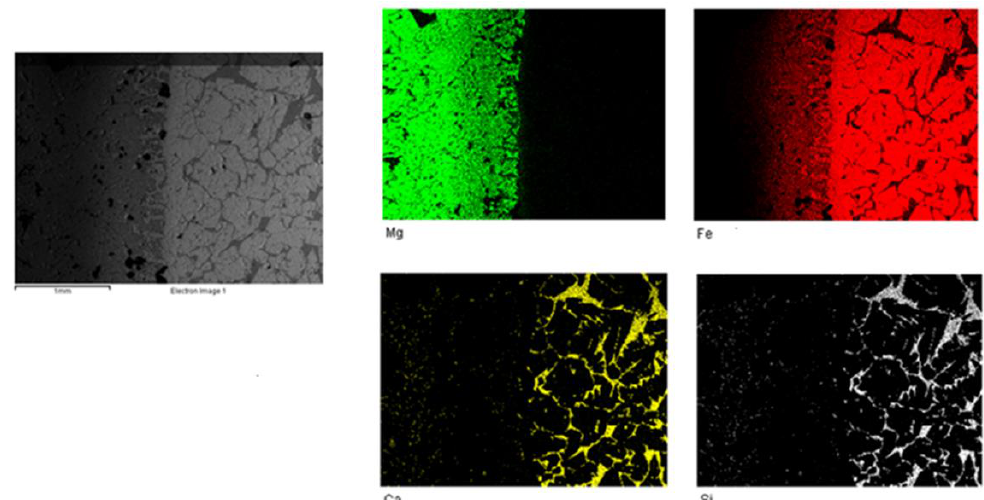
Figure 4. Surface mapping of major elements (experiment at 1650 ◦ C, contact time 2 h).